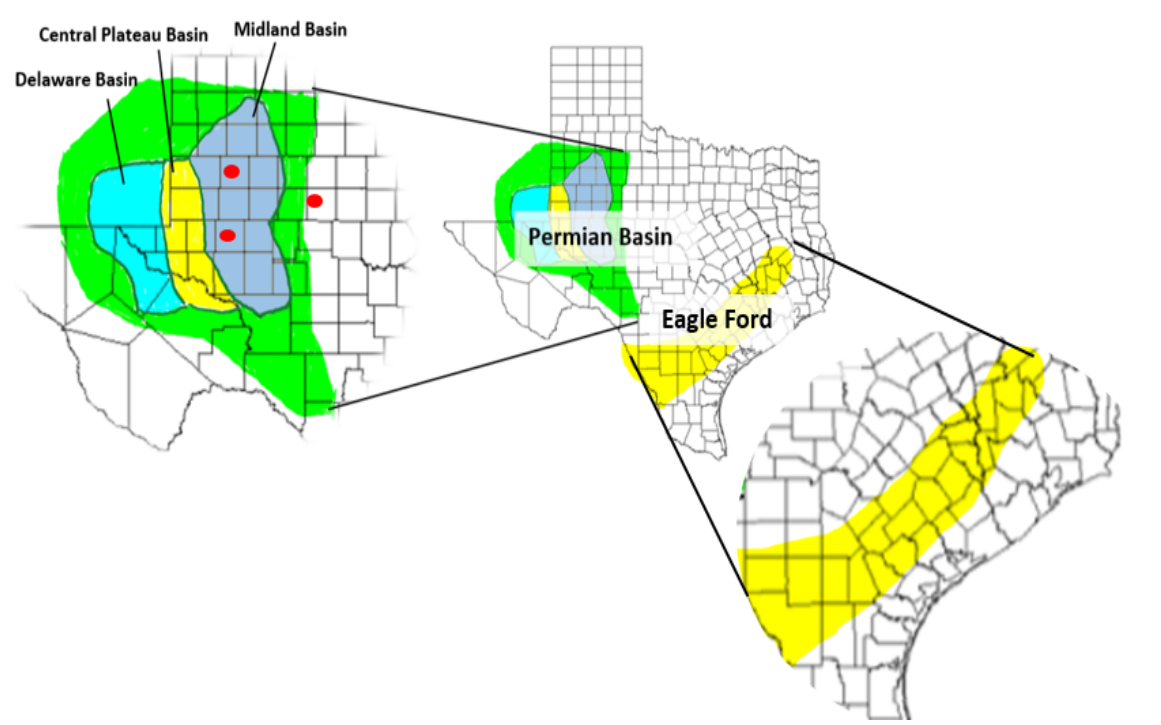
Figure 1. Sampling locations for the produced water samples in this study. Nine were collected from the Permian Basin: one considered FB from Nolan County, TX, one from a SWD well in Dawson County TX, and seven from a SWD in Midland County, TX. In total, 15 samples were collected from the Eagle Ford Shale: 13 from a PW treatment center in Bebe, TX, and two from EF production wells in Brazos County, TX.